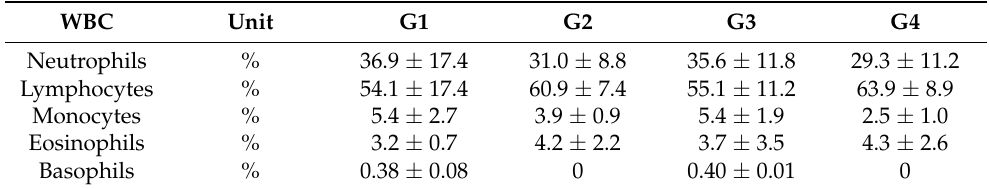
Table 1. Hematological result in mice administrated orally with or without INO95 and INO20 of repeated dose toxicity study. The average ± SD is given ( n = 5).